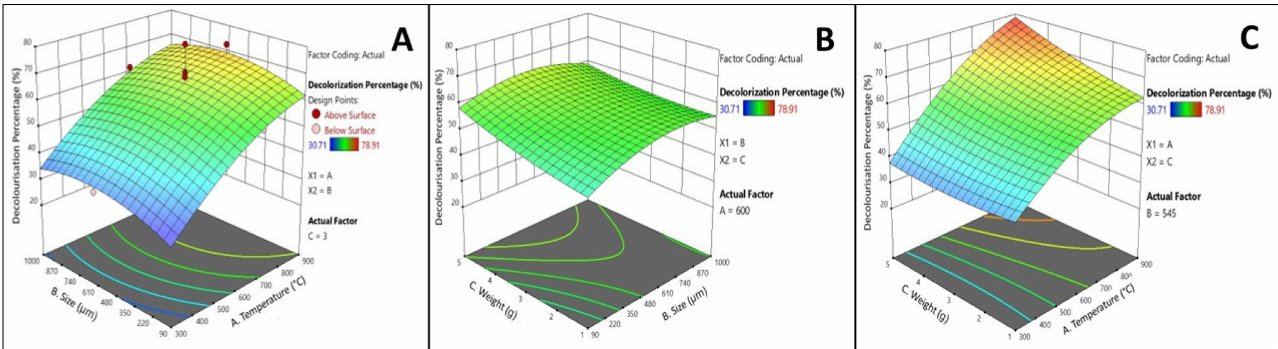
Figure 5. Response–surface curve (3-D plot) of dye decolourisation of STDW showing the interaction between ( A ) temperature vs size, ( B ) size vs weight and ( C ) temperature vs